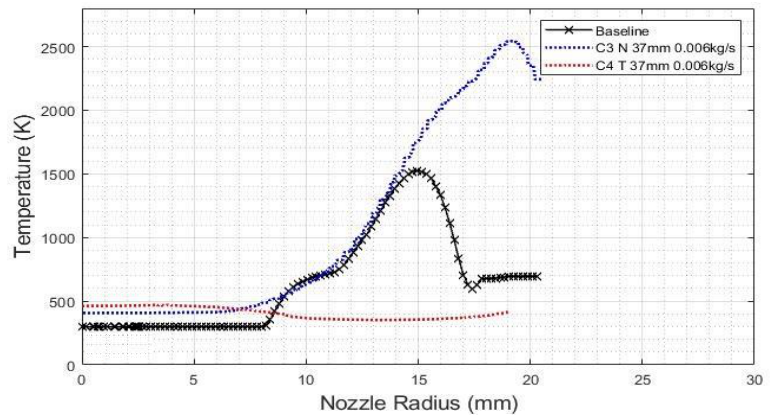
Figure 11. Static temperature vs. nozzle radius of C3 and C4.